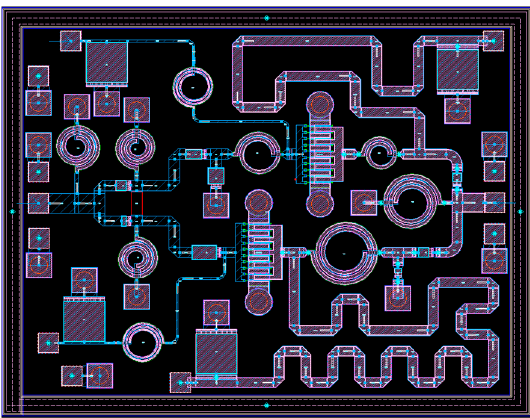
Figure 15. Layout of the DPA.